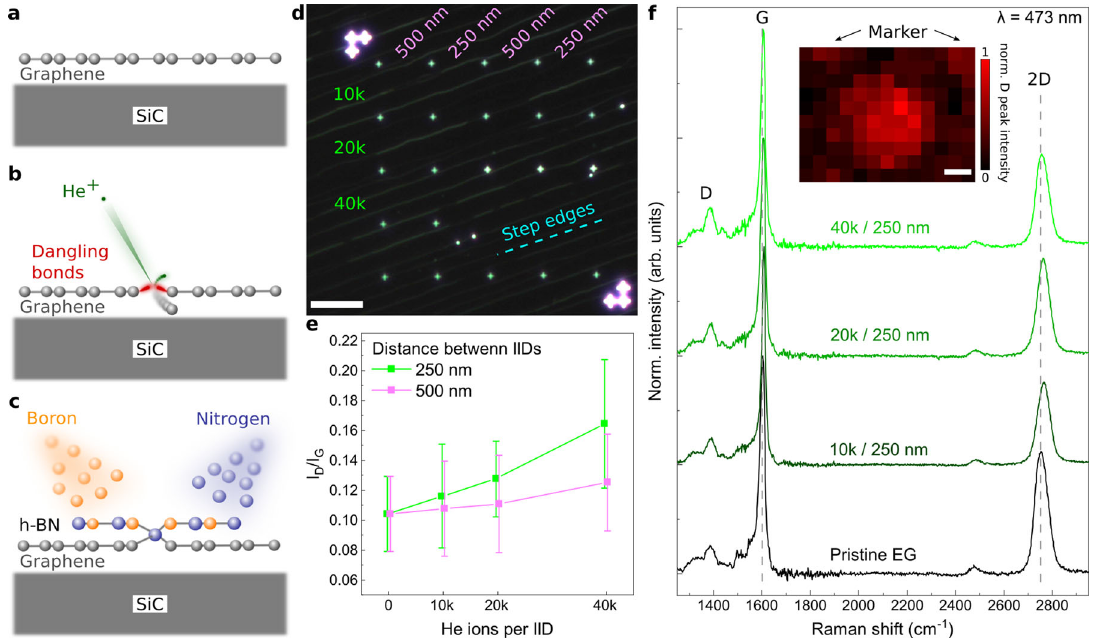
Fig. 1 Defect-engineering in EG on SiC via He FIB. a – c Schematic representation of the SAvdWE process. a Pristine EG fabricated via Si sublimation from SiC substrates. b Deterministic placement of IIDs in EG via He FIB. c Growth of h-BN via PAMBE, where dangling bonds at the defects act as preferential nucleation sites. For simplicity the C-rich interface layer to the SiC was neglected in these images. d Dark fi eld micrograph from structured area showing the 4 × 3 matrix of the FIB pattern, each containing 19 × 19 IIDs, written in a square grid with varying distance to each other and different number of He ions as indicated by magenta and green annotations, respectively. SiC step edges run parallel to the cyan dotted line. Additional cross-shaped markers were written between the different areas via He FIB. e Average ratio between D and G Raman peak intensity for 36 spectra recorded in each area in the FIB pattern. The two different data sets are laterally offset for clarity. The error bars represent one standard deviation. f Comparison of the mean Raman spectra of patterns with higher IID density written with varying number of He ions per defect. The spectra were normalized with respect to the G peak and vertically shifted for clarity. The gray dotted lines mark the position of the G and 2D peaks in pristine EG. Inset: Raman map of the D peak intensity marking the structured area containing 19 × 19 IIDs, each written with 40,000 He ions in a distance of 250 nm to each other, in between markers (indicated by black arrows). Scale bars, 10 μ m in ( d ), 2 μ m in the inset of ( f